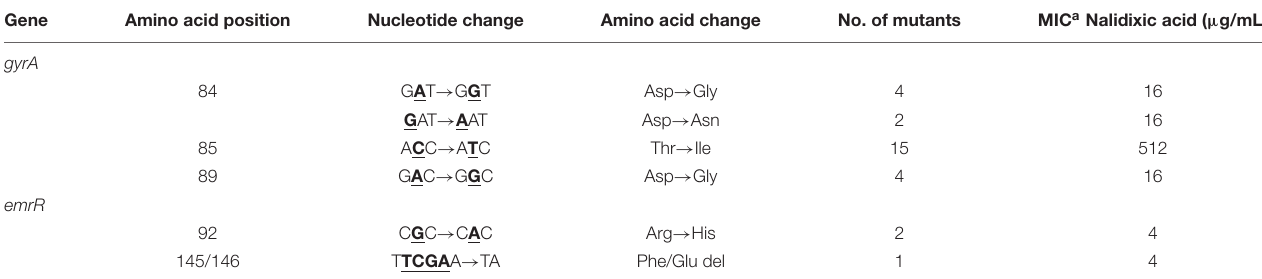
TABLE 3 | Point mutations and amino acid changes in emrR and gyrA genes associated with increased resistance to nalidixic acid in C. violaceum . Nucleotide